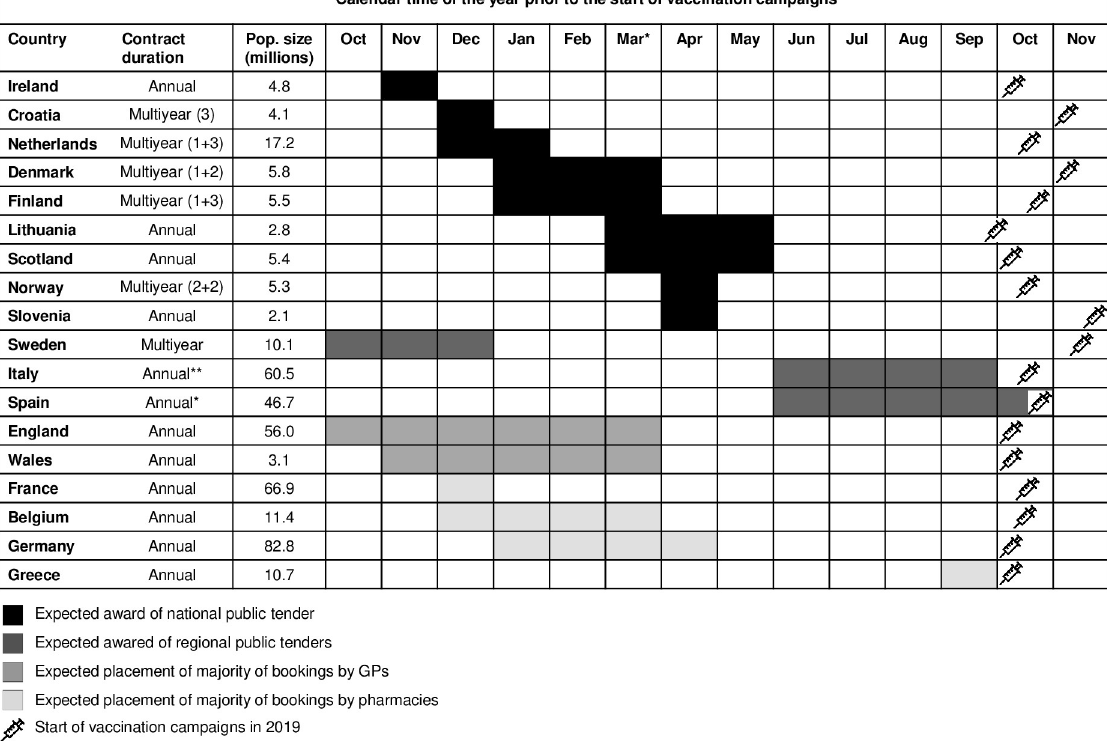
Fig 2. Expected timeframe of tender award or placement of majority of direct purchase bookings [16,17]. (x+y): x years + y optional years (optional for the buyer). � A small number of regions have multi-year tenders. Source population size: EUROSTAT and Office of National Statistics